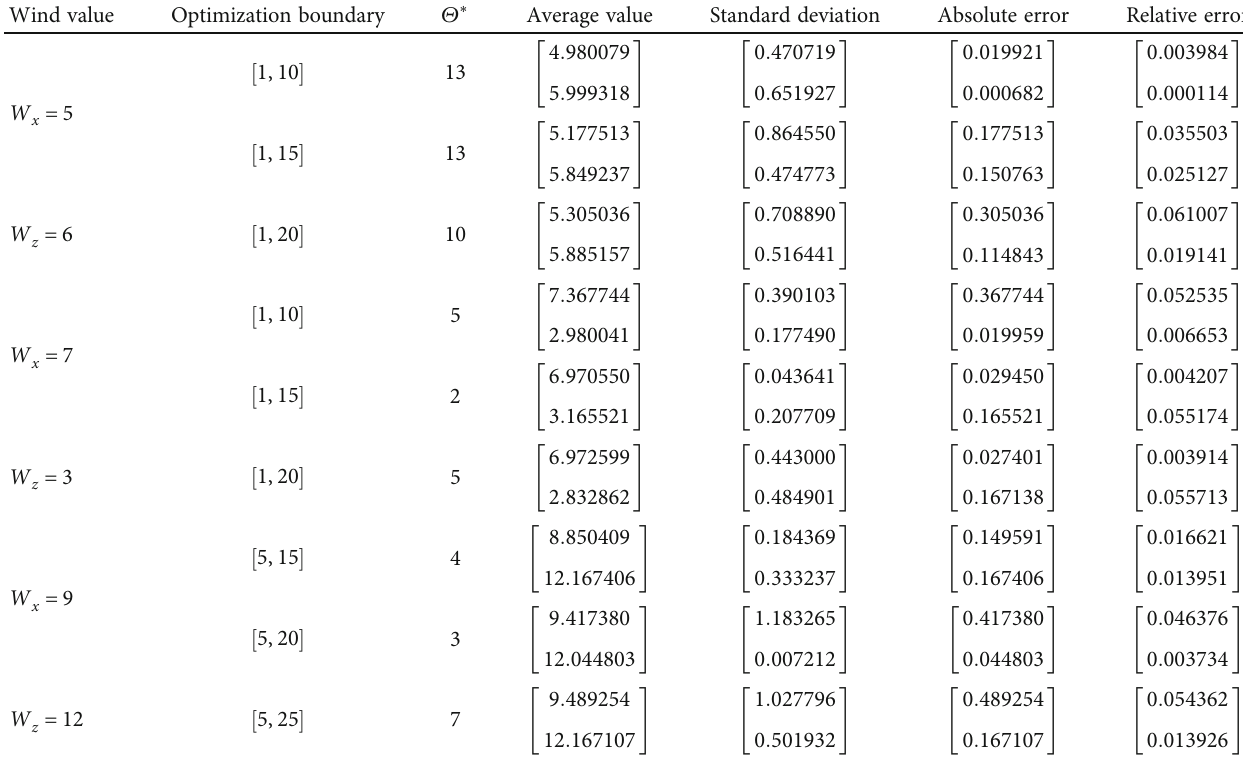
Table 1: Identi fi cation results of constant wind velocity components.